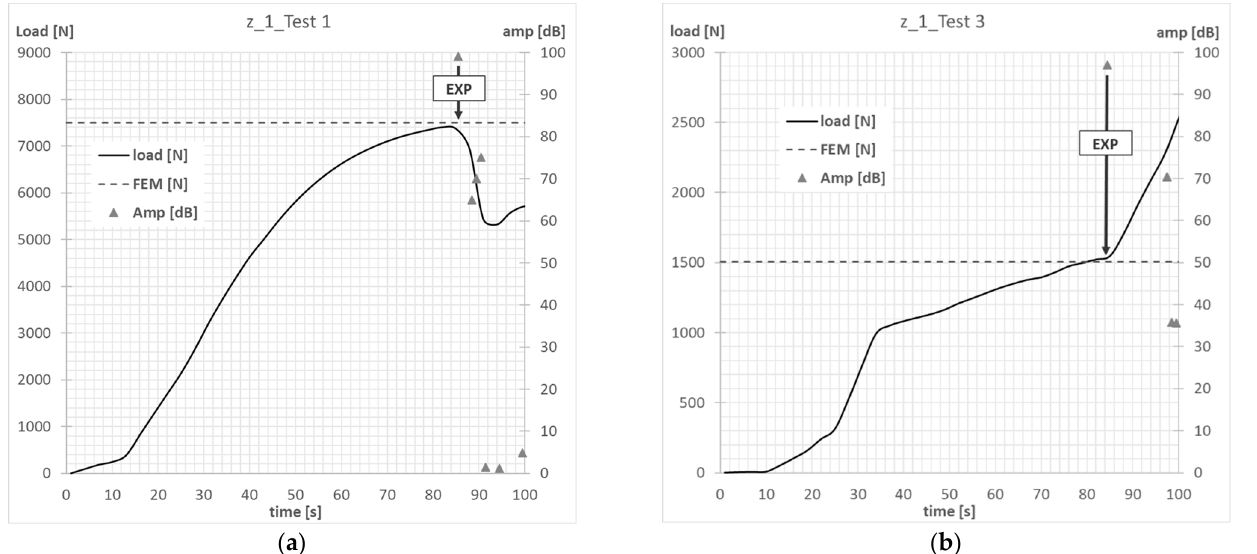
Figure 7. Column z_1—failure initiation force: ( a ) axial compression—Test 1; ( b ) eccentricity—Test 3.